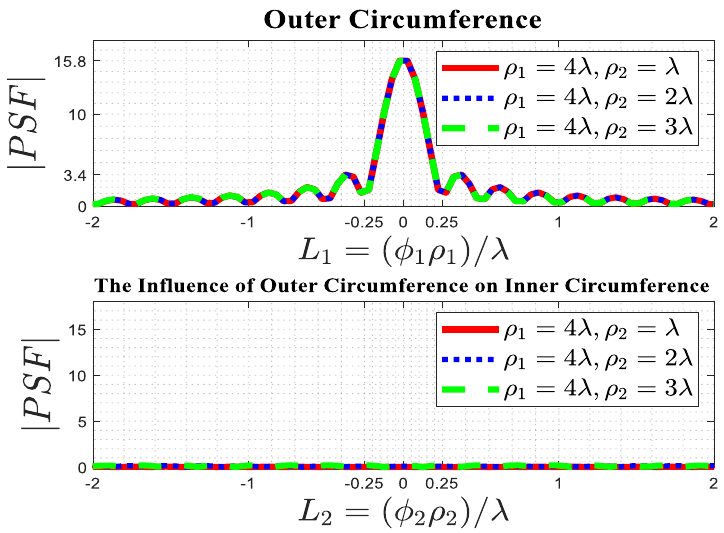
Figure 7. The PSF of the outer circumference and its effectiveness on the